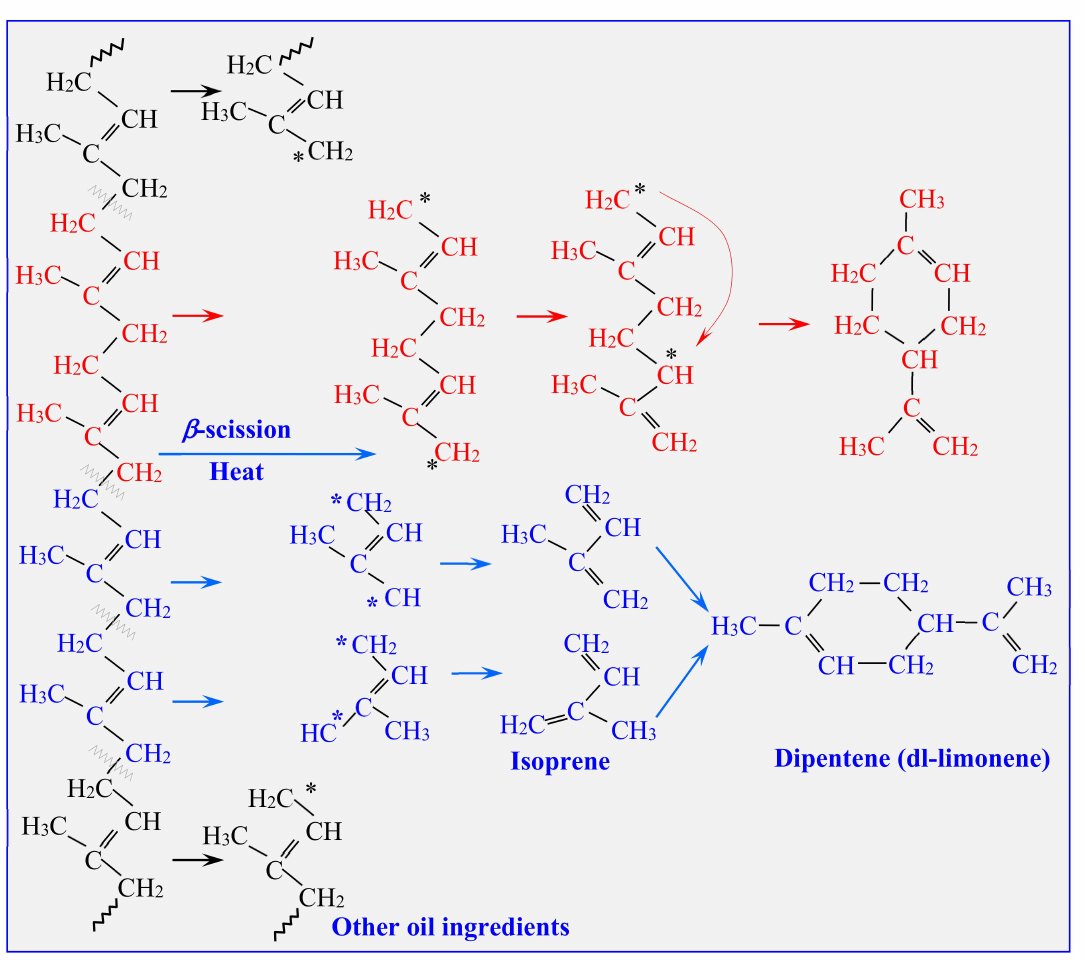
Figure 1. Scheme of two mechanisms for the pyrolytic decomposition of natural rubber to limonene based on